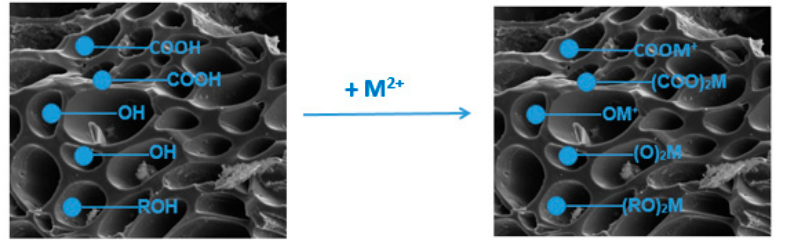
Figure 13. Scheme of the ion exchange on the biochar surface.